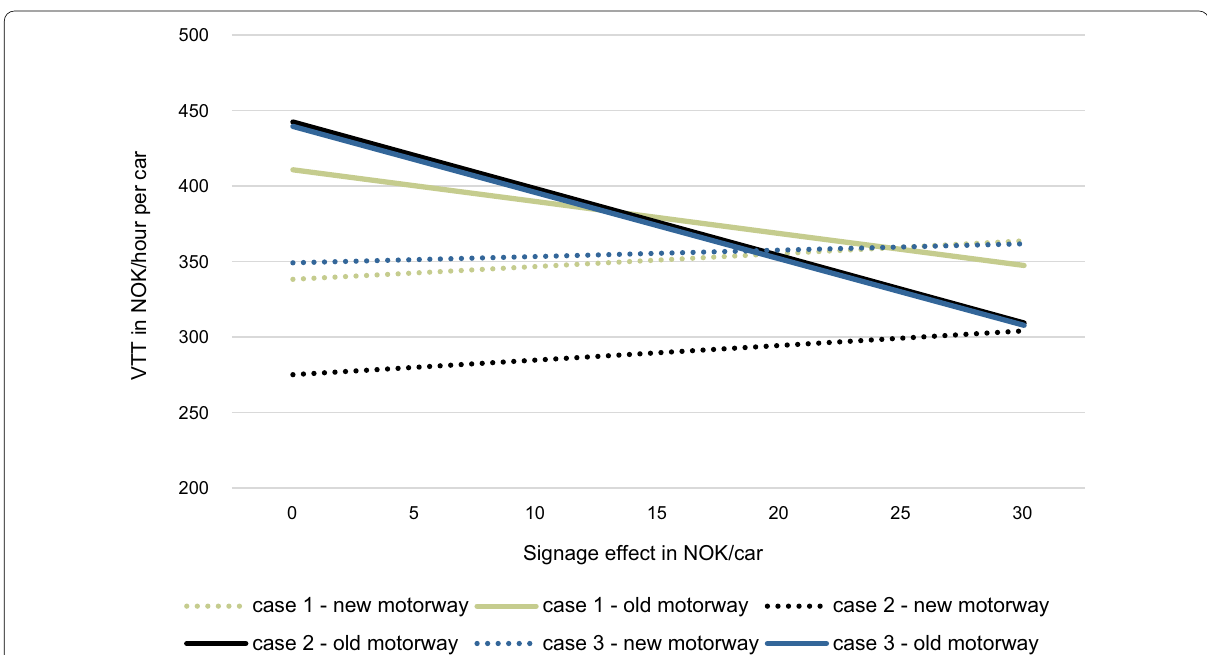
Fig. 3 Value of time on old and new road in each case study as a function of the signage effect, given average values of time as indicated in Table 3